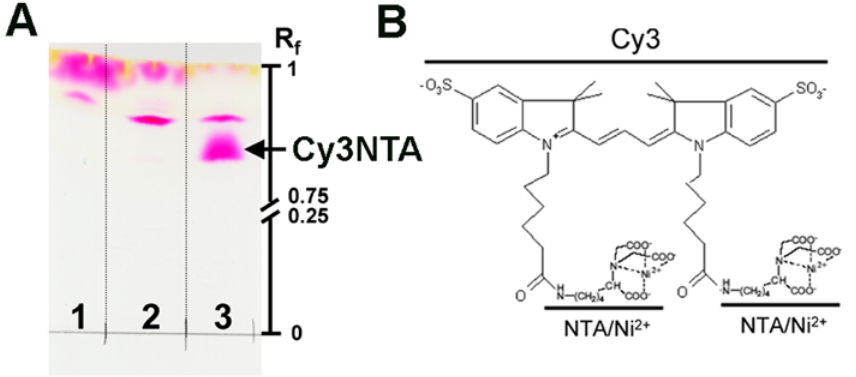
Figure 1. TLC analysis and structure of Cy3NTA. (A) Products from reactions consisting of Cy3-bis-succinimidyl ester alone (lane 1), Cy3-mono- succinimidyl ester and AB-NTA (lane 2), and Cy3-bis-succinimidyl ester and AB-NTA (lane 3) separated by TLC as described in Methods. Arrow indicates Cy3NTA used for FRET studies. R f =relative index of mobility. (B) Predicted structure of Cy3NTA. Locations of Cy3 and the two NTA/Ni 2 + moieties are indicated.